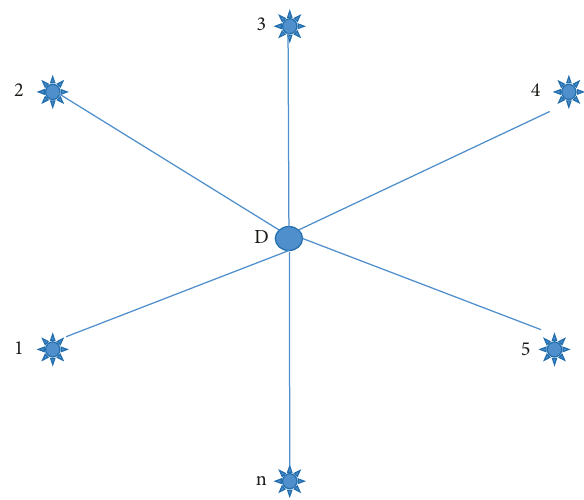
Figure 5: Schematic diagram of maximum likelihood estimation